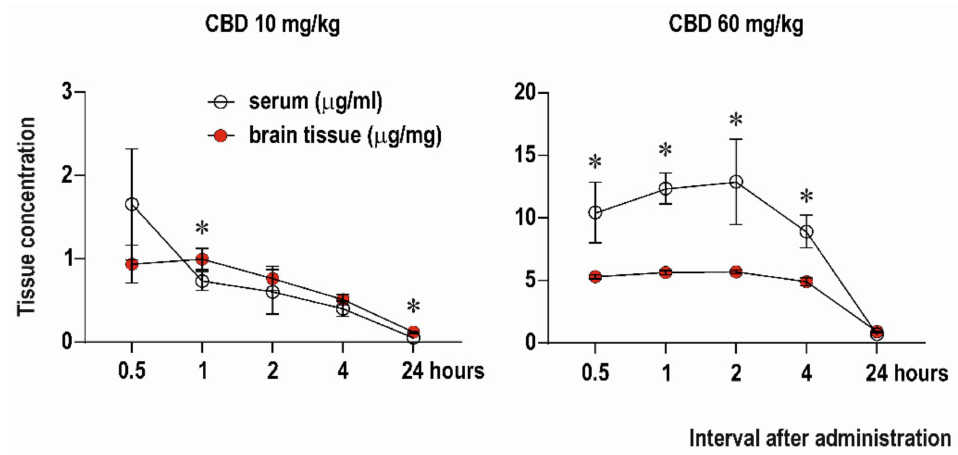
Figure 1. Tissue concentration of CBD. Levels of CBD in serum ( µ g/mL of plasma, empty circles) and in brain tissue ( µ g/mg of tissue, red circles) assessed in 5-time intervals after drug administration (0.5–24 h; axis x ). CBD was administered intraperitoneally in doses 10 mg/kg (left panel) or 60 mg/kg (right panel). Data are expressed as a mean ± SD. Asterisks denote a significant difference between plasma and brain